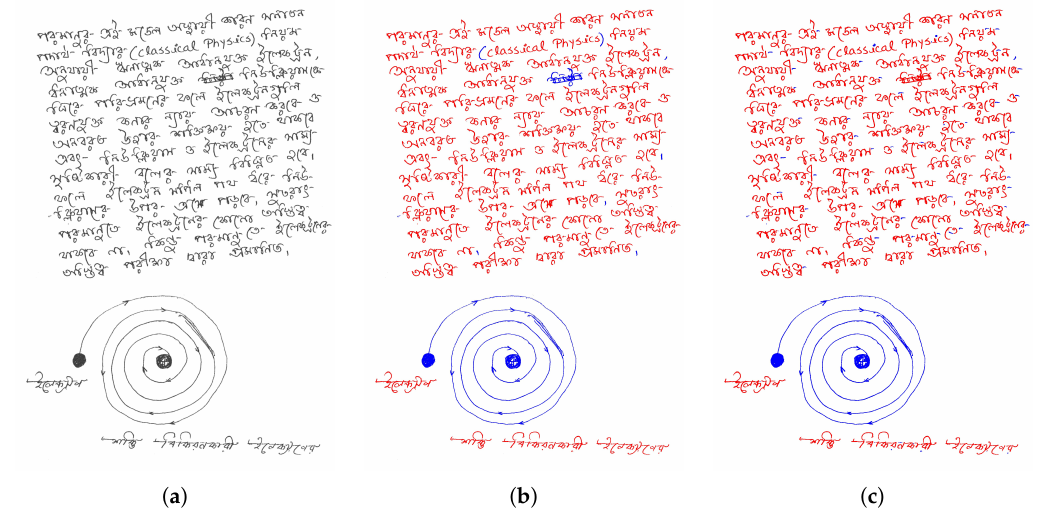
Figure 9. A Bangla handwritten document classified with RF classifier. Here, ( a ) grayscale image, ( b ) ground truth image, ( c ) result using RULBP. Table 2. Performance measure for text/non-text separation, using various LBP